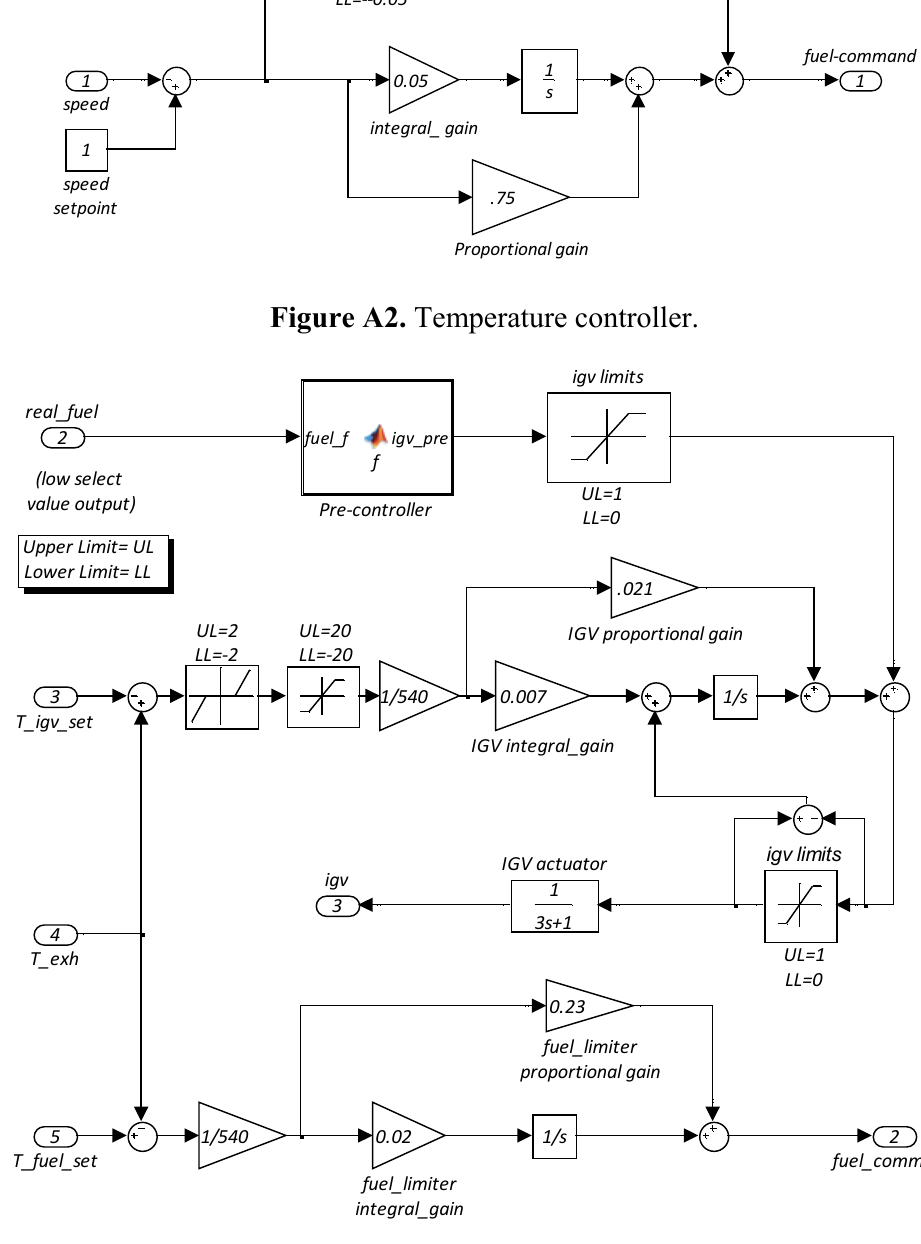
Figure A1. Governor (island mode).